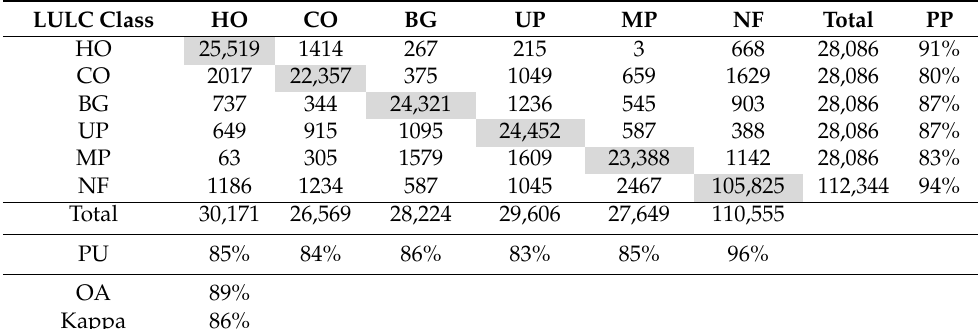
Table 5. Confusion